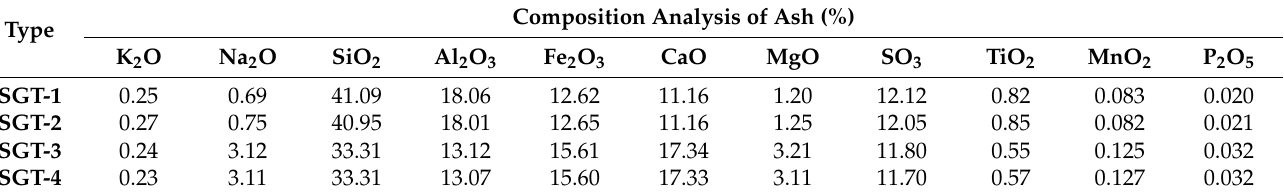
Table 4. The ash composition of coal